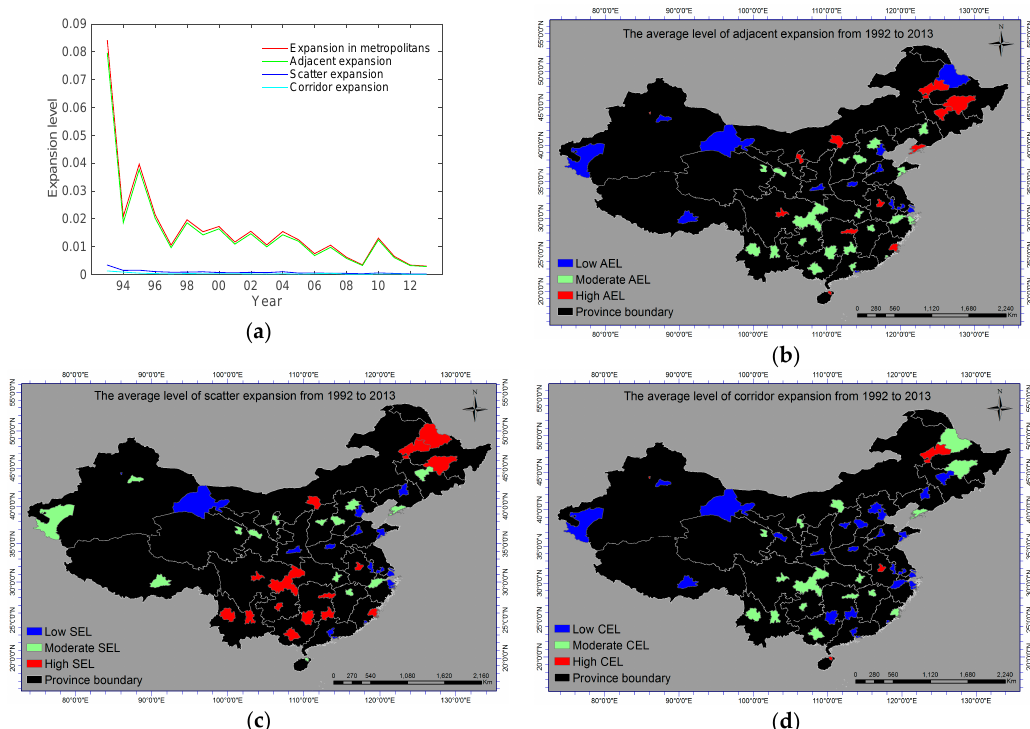
Figure 7. Characteristics of expansion: ( a ) Annual average EL ( AEL , SEL , CEL ) over years; and Map of the average values of ( b ) AEL , ( c ) SEL , ( d ) CEL for metropolitans.